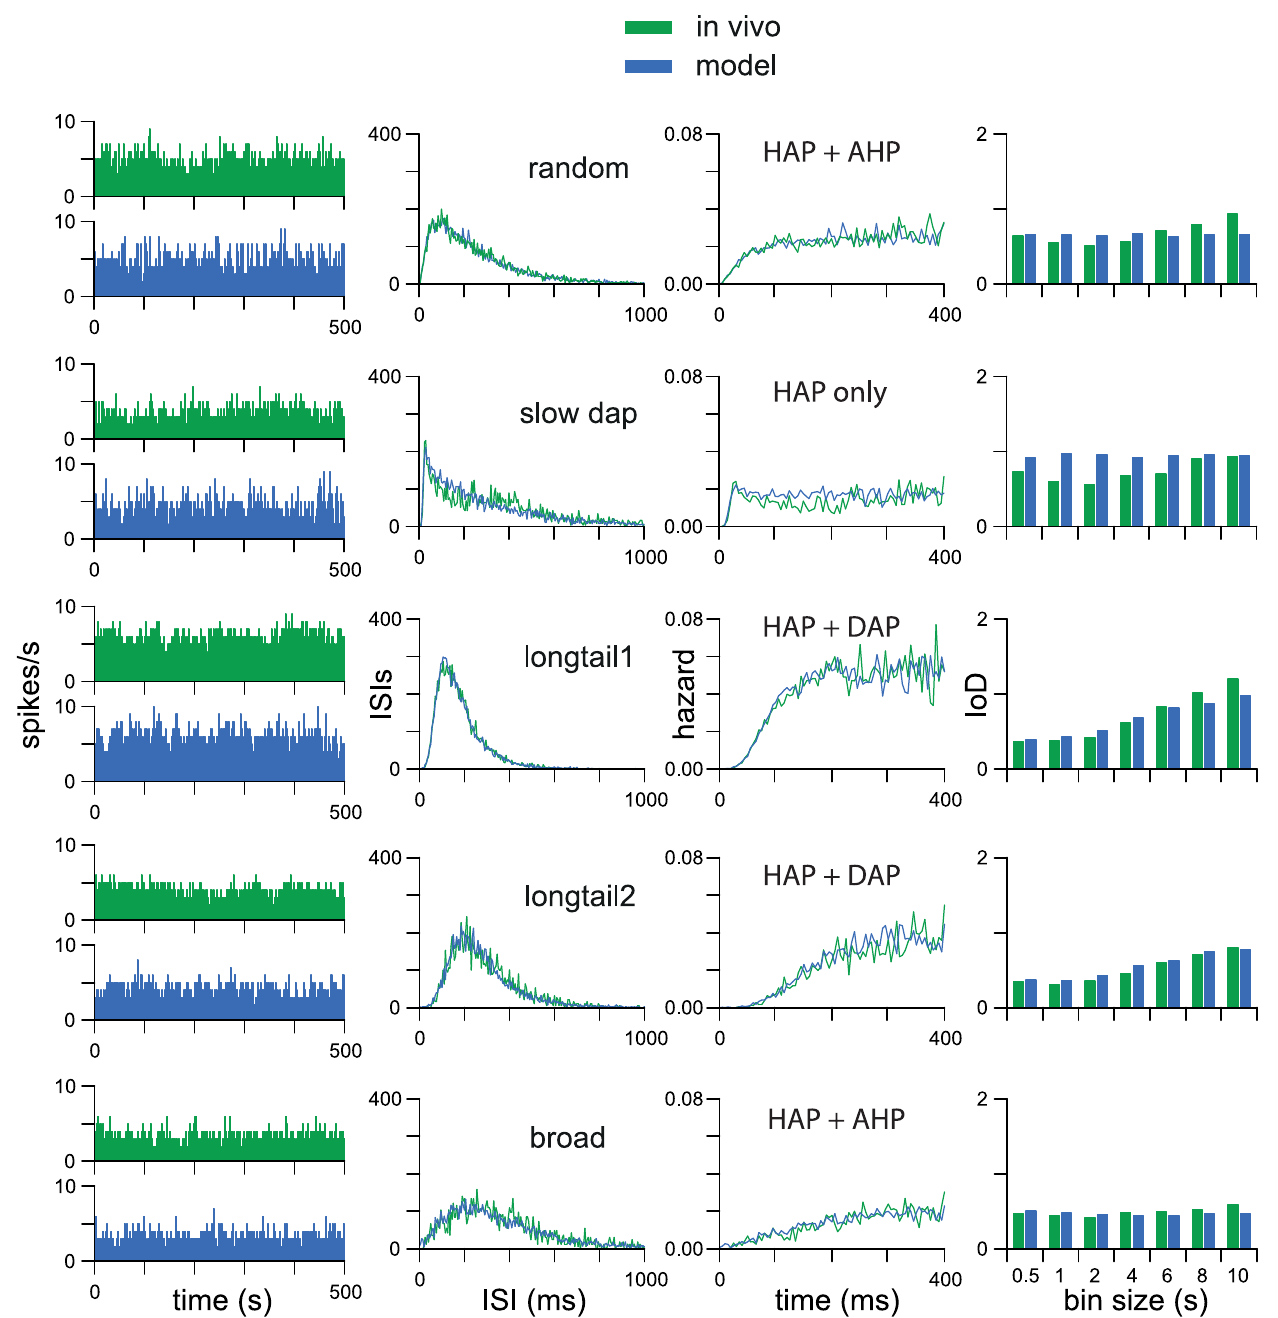
Fig 2. Single neuron model fits. Using automated fitting we produced close matches to the spike patterning of “random”, “slow DAP”, “longtail1”, “longtail2”, and “broad” type VMN neurons, using a single neuron integrate-and-fire based model receiving random synaptic input at a fixed rate. Each row shows a single neuron and its best model fit. The 1-s binned spike rate (1st column) shows the match to spiking rate and variability but not detailed patterning. The fit is measured using a weighted sum of the match to the ISI distribution (2nd column), the hazard function (3rd column), and the IoD range (4th column). The best fits use either just an HAP, an HAP and an AHP, or an HAP and a DAP, indicated in the 3rd column. The early mode in the ISI distribution of the “random” and “slow DAP” type neurons indicates a short refractory period, corresponding with a faster (shorter half-life) HAP fit than in the “longtail1”, “longtail2”, and “broad” type